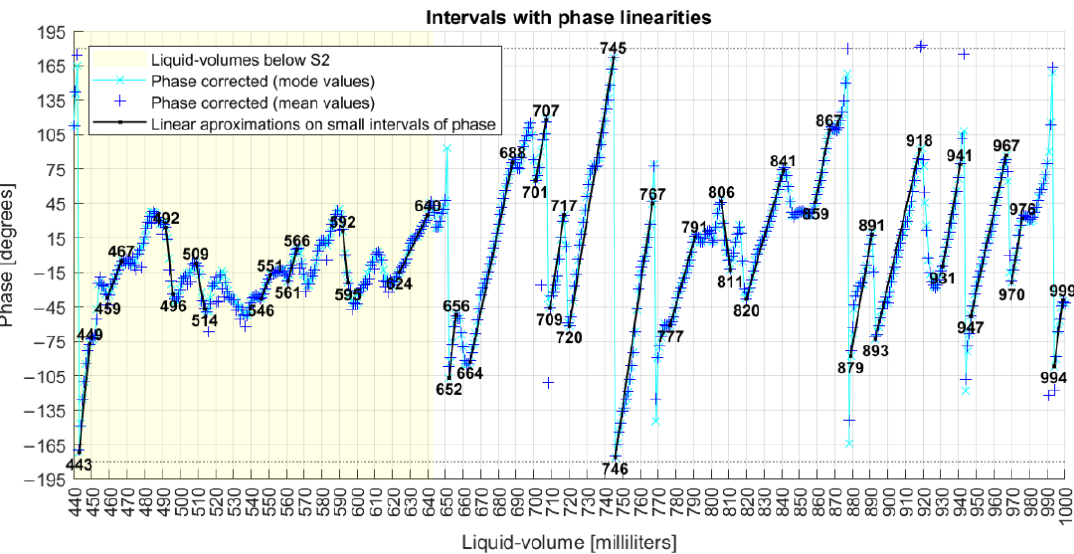
Figure 10. Liquid volume intervals with linearities with phase.